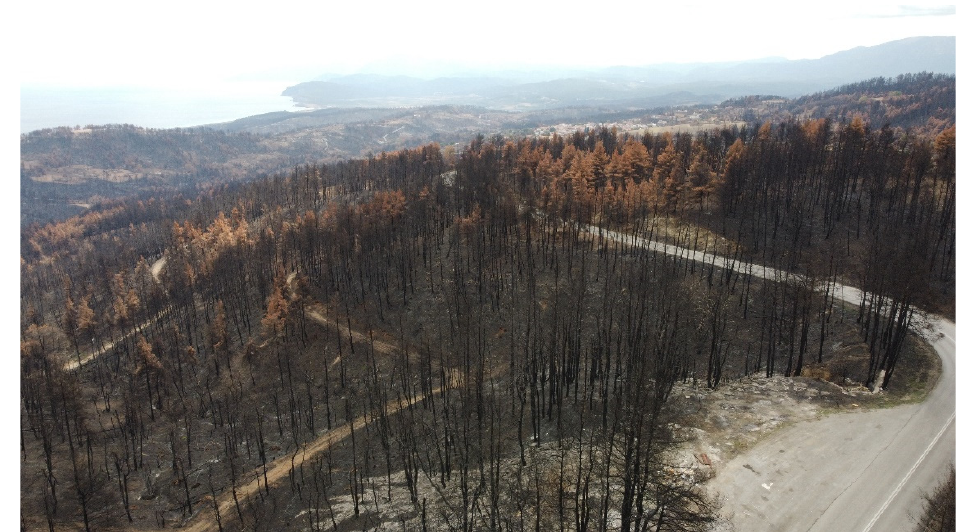
Figure 4. Part of the fire-affected area in northern Euboea on 3 September 2022.